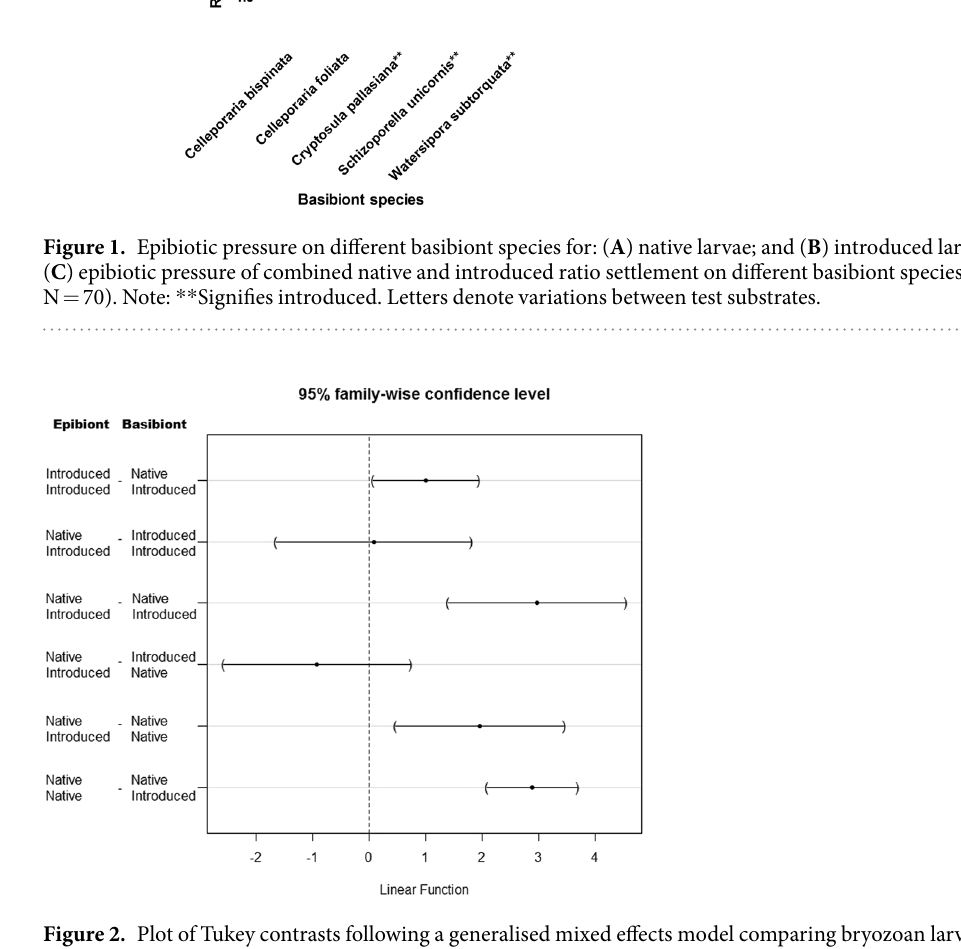
Figure 2. Plot of Tukey contrasts following a generalised mixed effects model comparing bryozoan larval settlement as epibionts on encrusting bryozoan